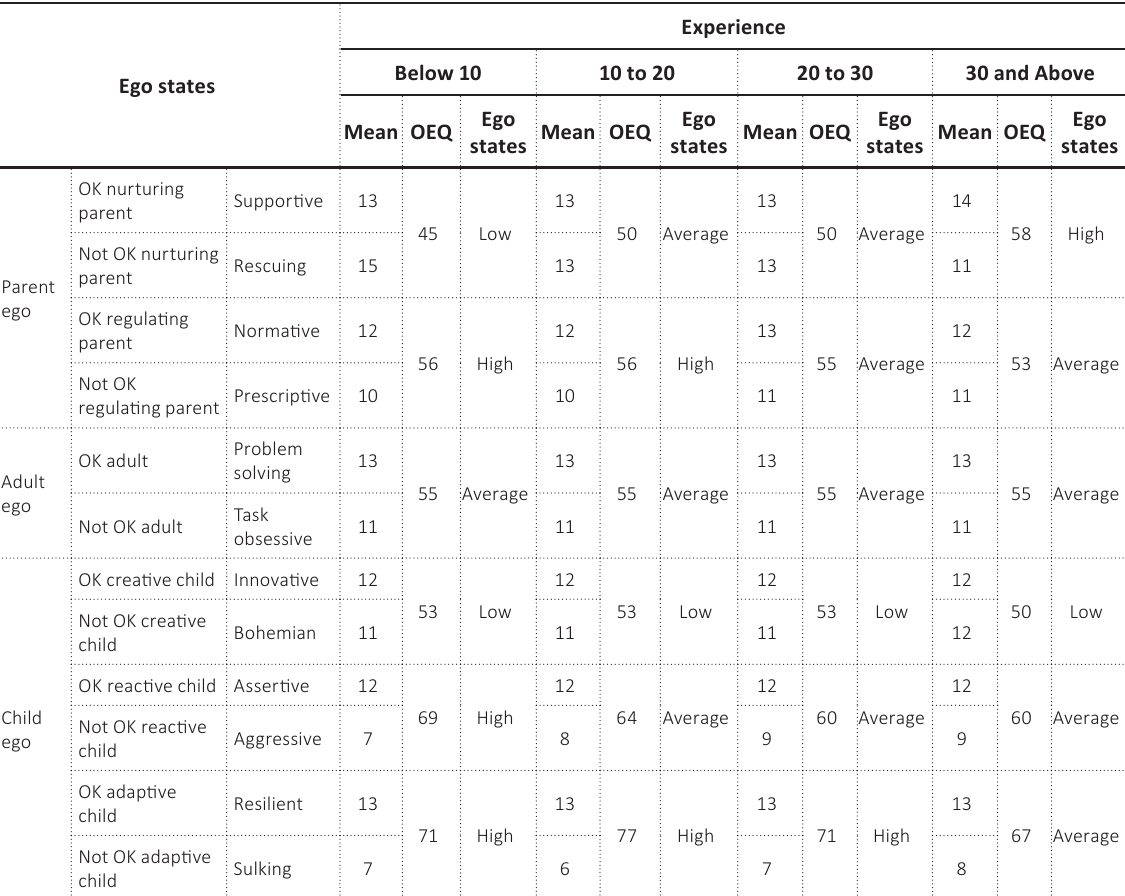
Table 4. Level of ego states based on age